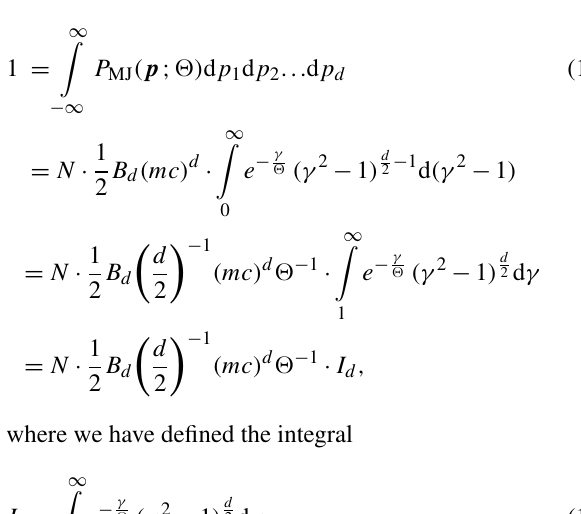
Figure 1. The MJ distribution of the electron kinetic energy E k = E 0 (γ − 1 ) with E 0 = 511keV, plotted for various temperatures T = 1keV–1MeV, and for dimensionality (a) d = 3 and (b) d = 2. For distribution values > 10 − 9 and temperatures less than T ∼ 10keV, the MJ distribution is well-approximated by the classical MB distri- bution, while the differences between the two distributions are more clear for T ∼